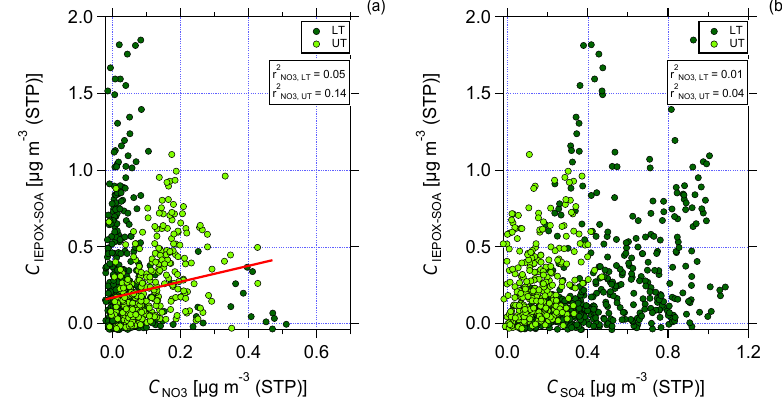
Figure 8. Scatter plot of C( IEPOX-SOA ) against nitrate (a) and sulfate (b) mass concentrations for the lower troposphere (dark green, LT) and upper troposphere (light green, UT). Data are averaged over 2min and presented together with the values for Pearson’s r 2 for the correlation between C( IEPOX-SOA ) and nitrate (a) and sulfate (b) mass concentration for LT and UT, respectively. In (a) linear regression for the correlation between C( IEPOX-SOA ) and nitrate mass concentration in the UT is presented.